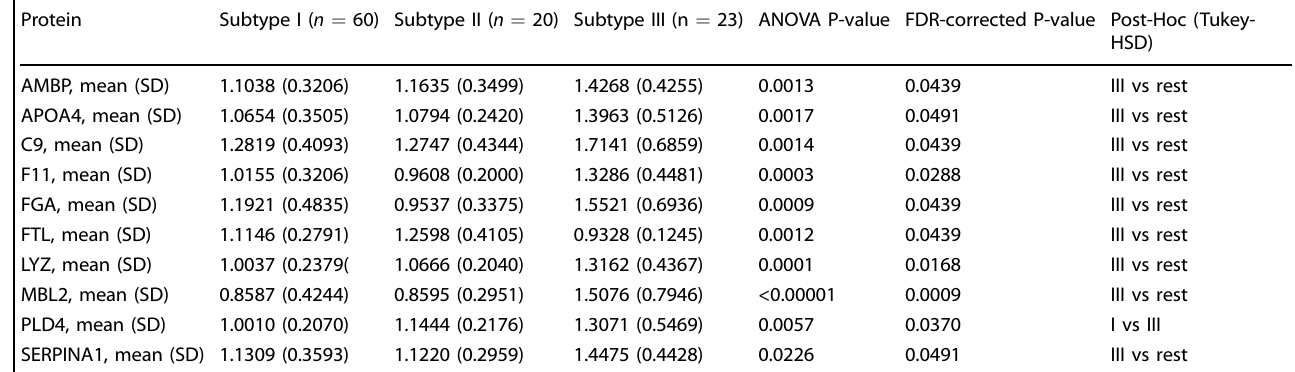
Table 2. List of statistically signi fi cant proteins between clusters (Numerical values are relative quanti fi cation of each protein in CSF). Protein